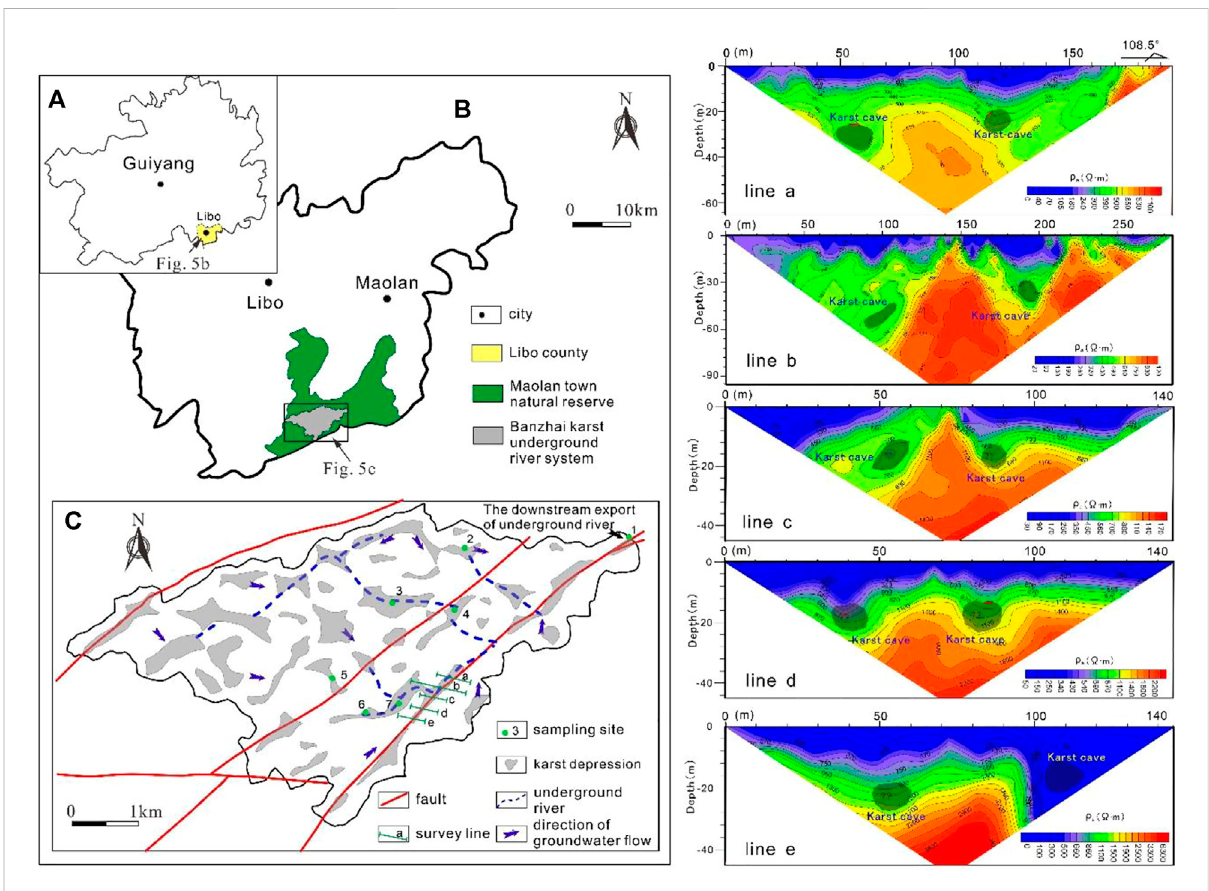
FIGURE 5 Location of the karst-developed areas in Banzhai village and the apparent resistivity quasi-section intersected by the Banzhai fault; the geographical location of Figure 5A is shown in Figure 1A; (A) geographic outline of Guiyang Province; (B) location and geographic outline of Libo county and Maolan natural reserve; (C) hydrogeological sketch map of the Banzhai underground River system, where there is the target area.